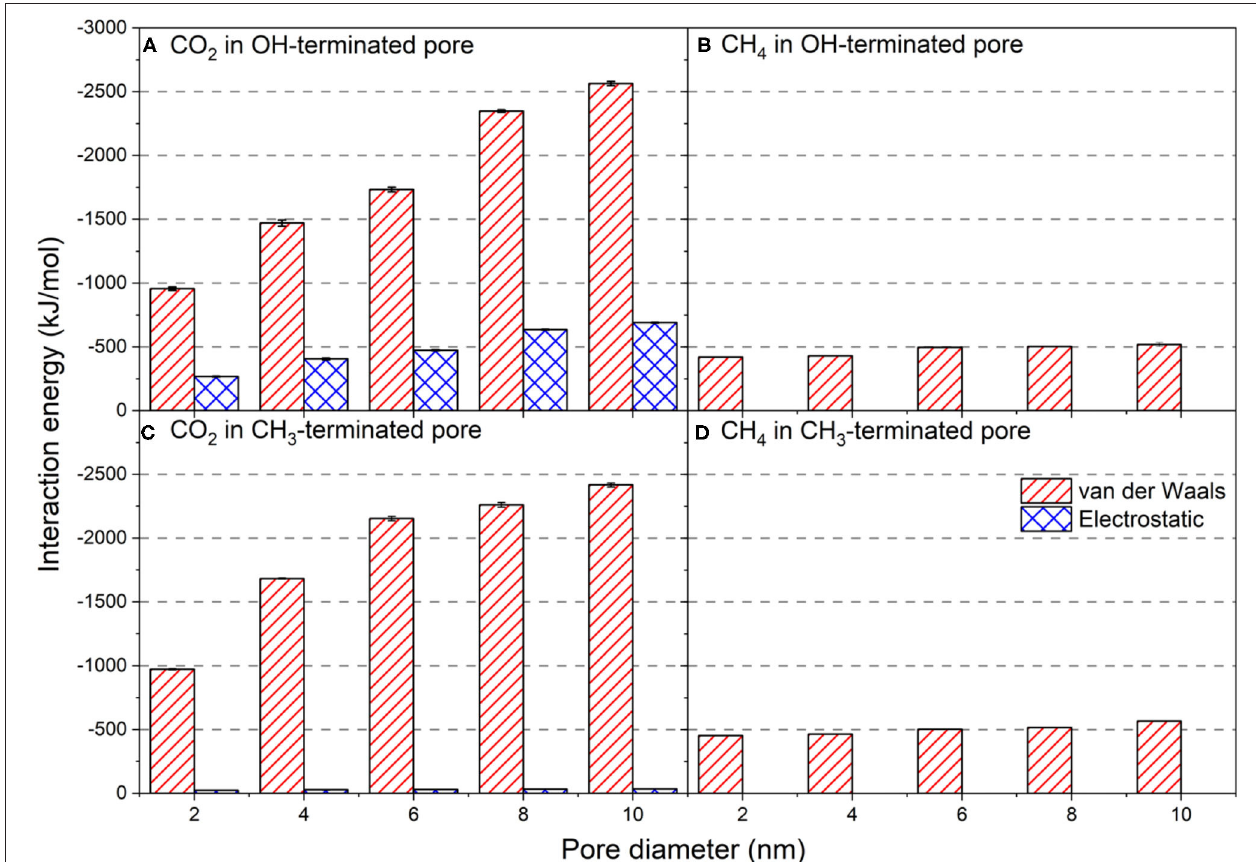
FIGURE 10 | Van der Waals and electrostatic interaction energies of CO 2 and CH 4 with (A,C) OH-terminated and (B,D) CH 3 -terminated pores as a function of the pore diameter. The intermolecular interactions are averaged over the last 10 ns of the simulation time. Error bars represent the standard deviation from the means values of three different